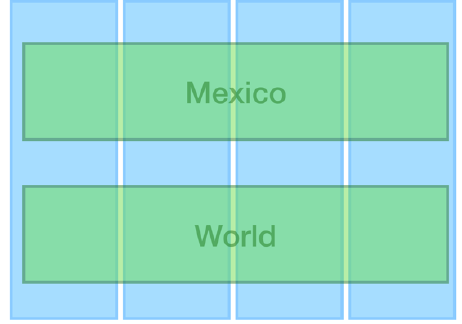
Figure 3: Regional elements in the Mexican Curriculum (blue: thematic elements, green: Regional Geography) Source: the